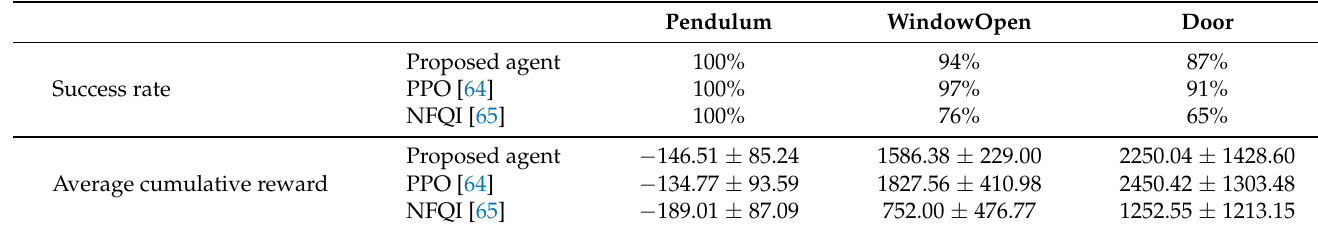
Table 3. The performance of the proposed agent on source tasks.